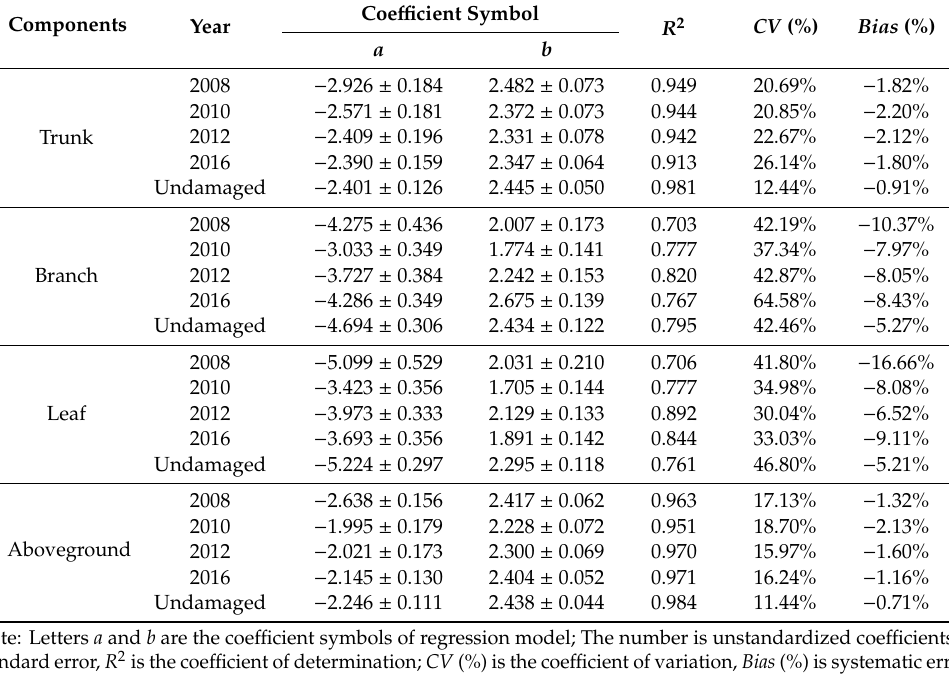
Table 2. Allometric models for estimation of biomass of trunks, branches, leaves and total aboveground biomass at di ff erent recovery stages after the ice storm disaster.